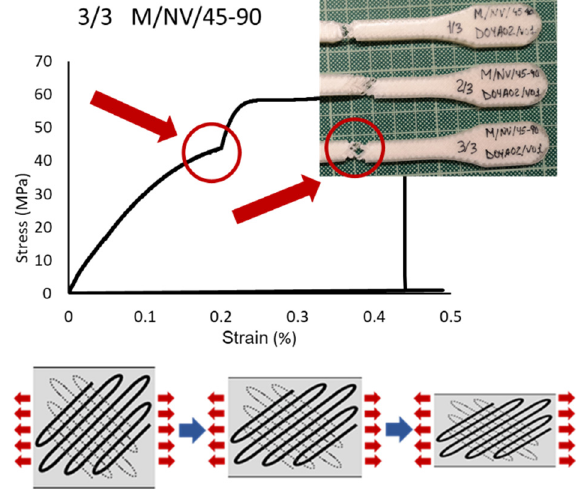
Figure 17. Breakage detail of M/NV/45-90 specimen, stress-strain graph and drawing “X” behavior scheme of the fiber.